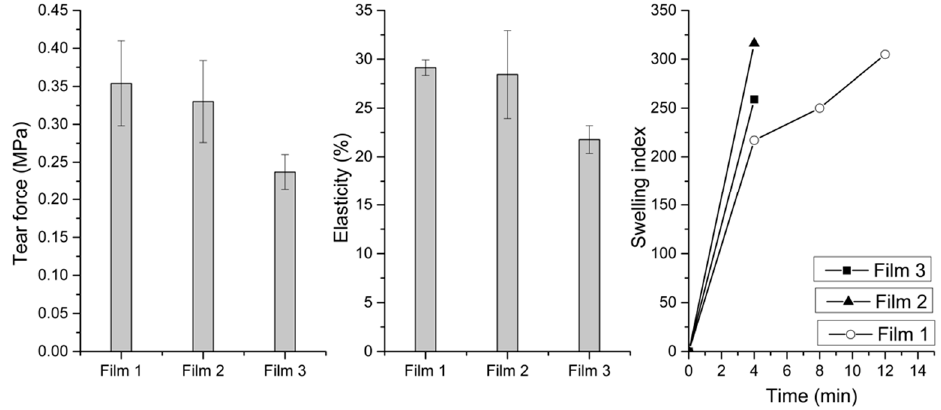
Figure 6. In vitro tensile strengths, elasticity and swelling index study of Films 1, 2 and 3.